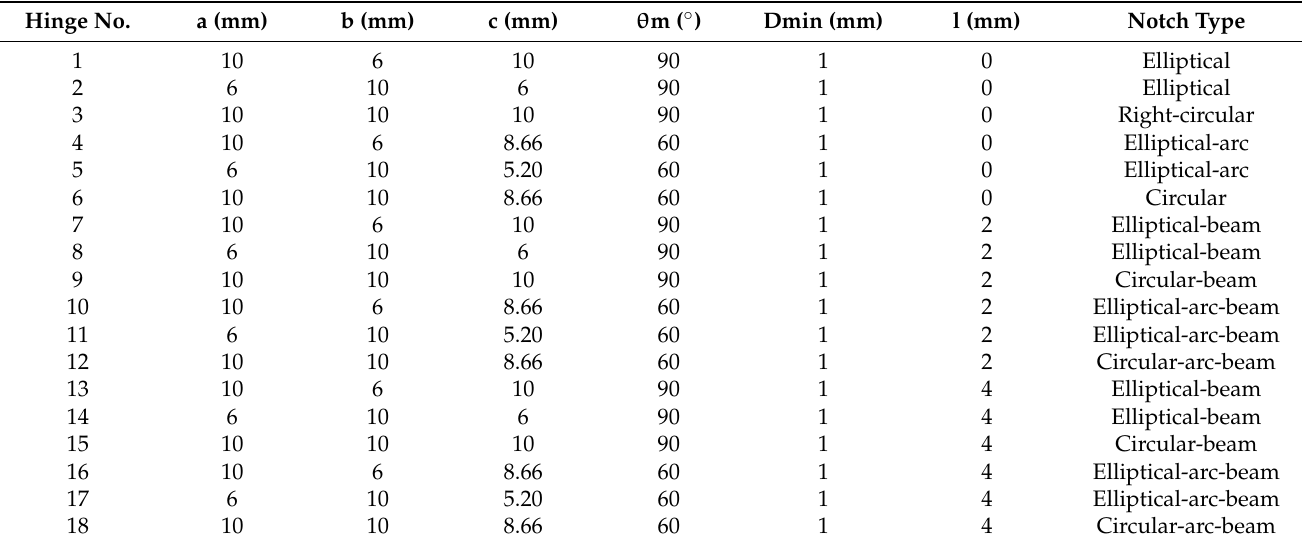
Table 3. Geometric parameters of the elliptical-arc-beam spherical flexure hinges in FEA. Hinge